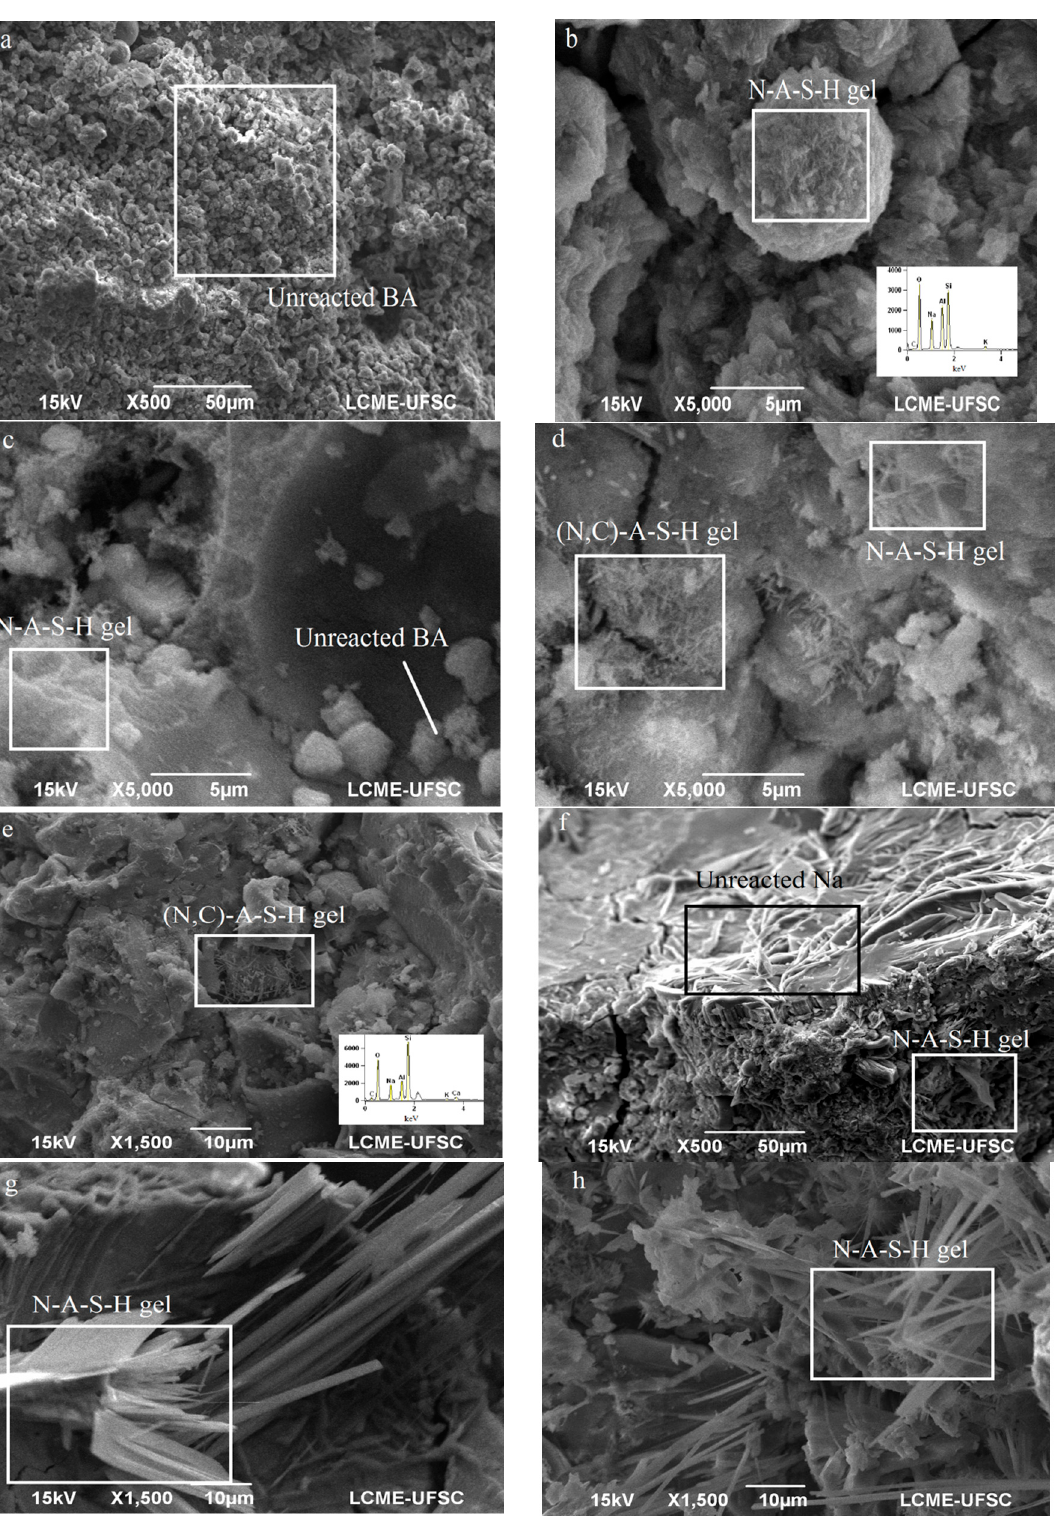
Figure 13. SEM analysis samples at 28 days: ( a ) OPC 0; ( b ) OPC 2.5 with EDS microanalysis from N-A-S-H gel; ( c ) OPC 5; ( d ) OPC 10; ( e ) OPC 30 with EDS microanalysis from (N,C)-A-S-H gels; ( f ) RHA 25; ( g ) RHA 50; ( h ) RHA 75 at 28 days.